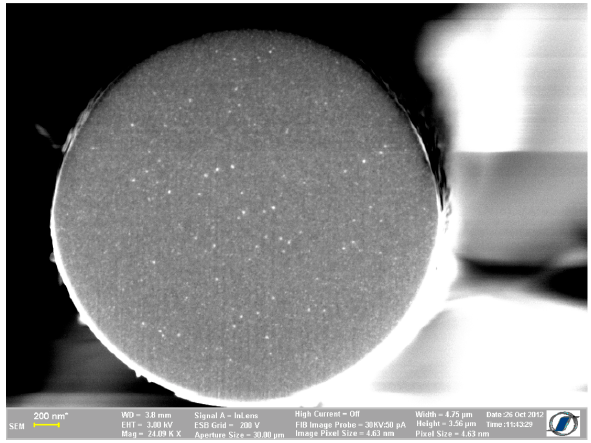
Figure 7. SEM micrograph of a glass-coated Fe 73.5 Cu 1 Nb 3 Si 13.5 B 9 thin microwire sample after annealing for 60 min at 550 °C.